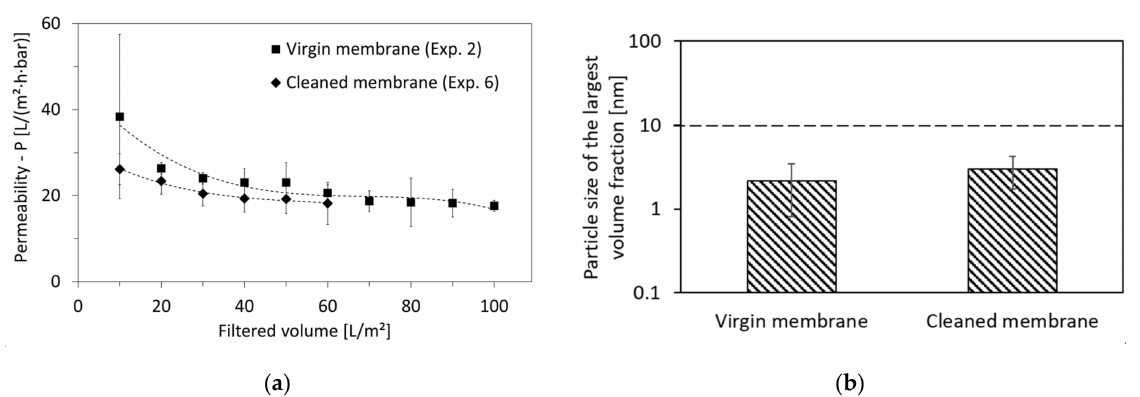
Figure 8. ( a ) Comparison of permeability of HTL-WW and ( b ) permeate quality based on the particle size of largest volume fraction of produced permeates, both in experiments performed using the membrane-pore size of 10 nm on a virgin membrane (experiment 2) and on a cleaned membrane after being used for several weeks (experiment 6).